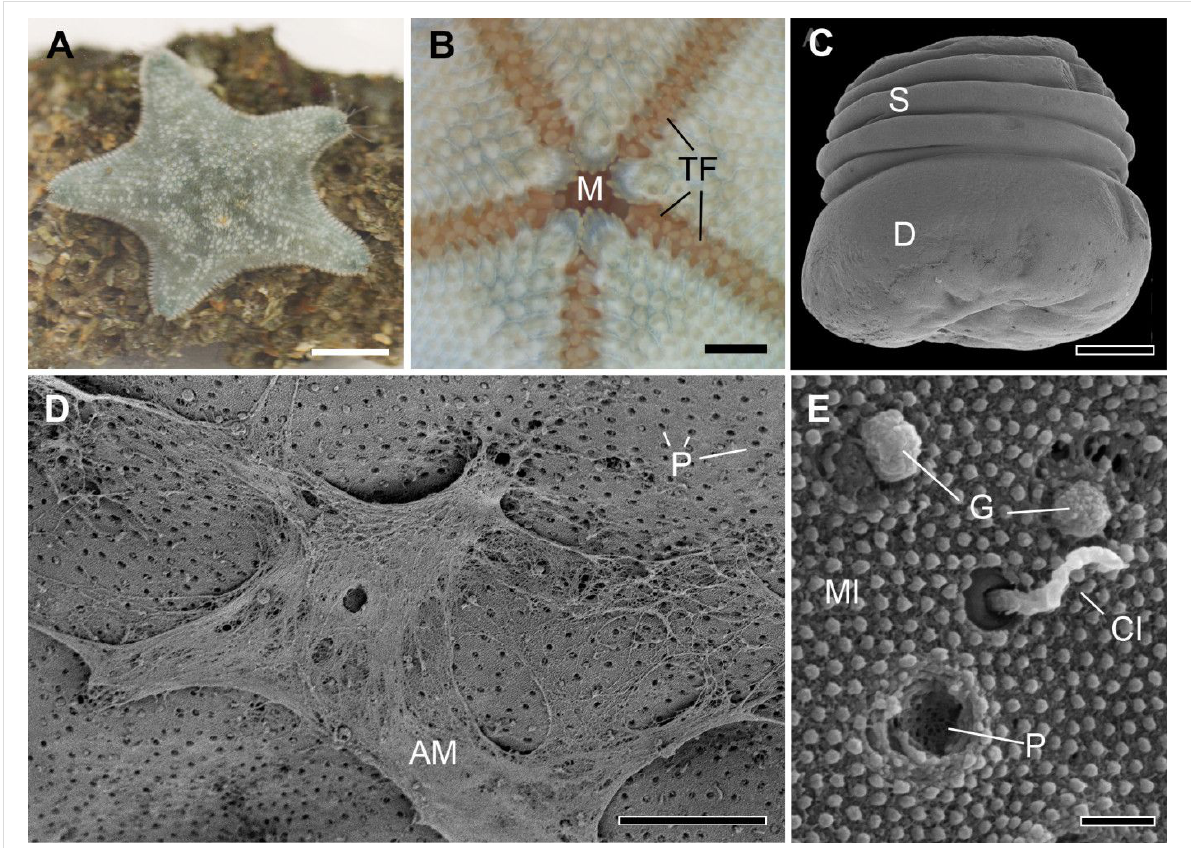
Figure 1: External morphology of the sea star Asterina gibbosa and of its tube feet. (A) Image of a living adult, attached to a rock. (B) Oral side of an adult, showing the arrangement of the tube feet in the ambulacral grooves along the five arms. (C) Overview of an amputated tube foot with SEM. (D) SEM image of the disc distal surface with a layer of adhesive material. (E) Details of secretory pores and cilia (SEM). AM - adhesive material; CI - cilia; D - disc; G - granule; M - mouth; MI - microvilli; P - pores; S - stem; TF - tube feet. Scale bars: (A) 1 cm; (B) 0.2 cm; (C) 100 µm; (D) 10 µm; (E) 0.5